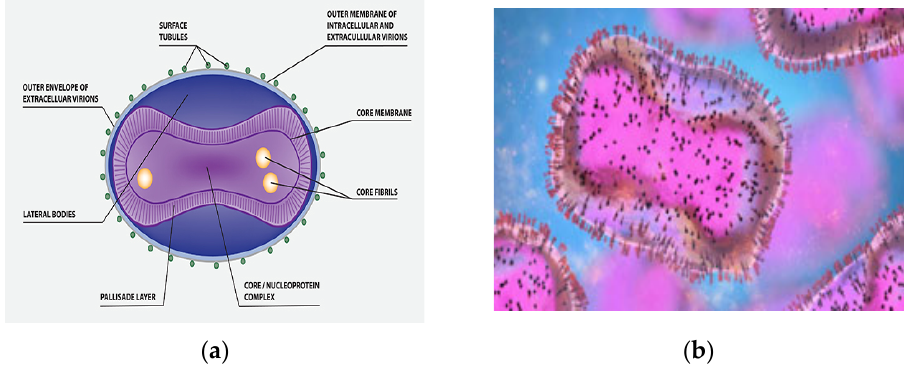
Figure 1. ( a ) MPXV molecular structure. ( b ) An electron micrograph displaying oval-shaped mature virus particles (pink) and immature particles (blue), taken from a sample from a patient with monkeypox.